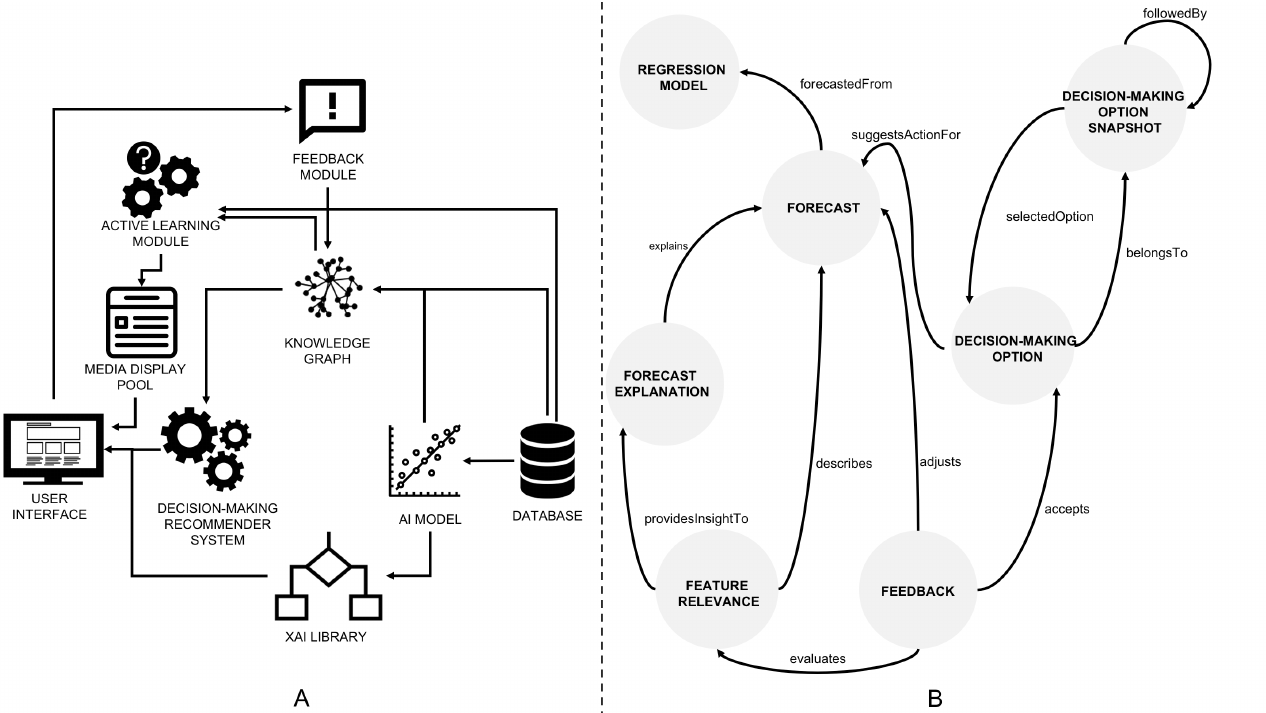
Figure 1. ( A ) displays a diagram of the system components and their interaction. ( B ) shows the main ontology concepts we considered, and their